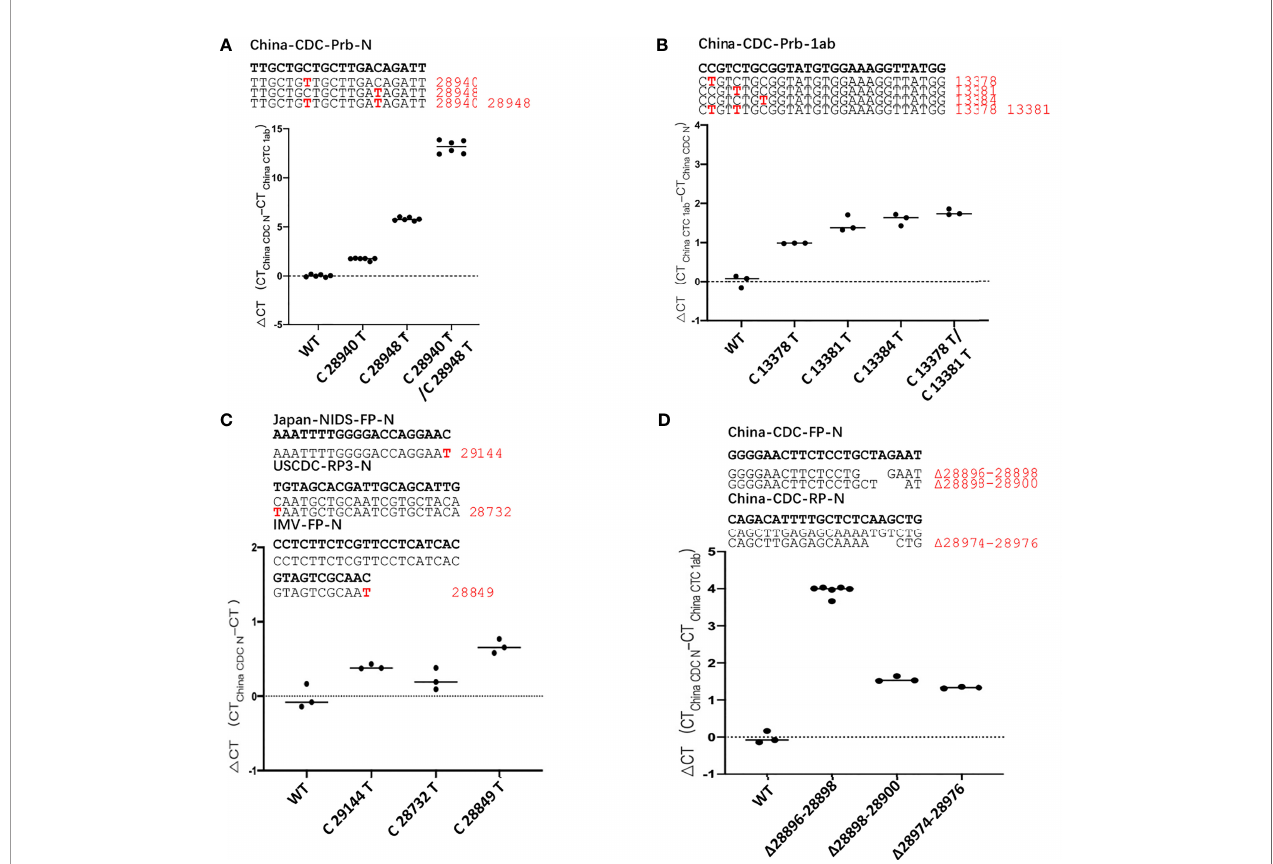
FIGURE 2 | The mutation of SARS-CoV-2 leads to poor detection of qPCR. D Ct values for testing of the standard plasmid and the mutant plasmid (A, B) mutations in the probe, (C) mutations in the 3 ’ -end of primer, (D) deletion mutant on primer using primer/probe sets by qPCR. The red letters represent the mutation bases, and the red numbers represent the mutation positions. All plasmid used in the fi gure are 8.5 x 10 2